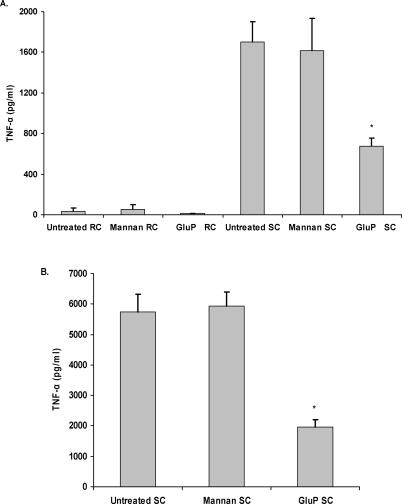
Competitive Carbohydrate Blockage Indicates No Role of Mannan Receptors in the Inflammatory ResponseAlveolar macrophages (A) or RAW 264.7 macrophages over-expressing dectin-1 (B) were pretreated with 250 μg/ml S. cerevisiae-derived mannan or 100 μg/ml glucan phosphate and then added to RC or SC. Thereafter, cytokine and chemokine levels were determined in supernatants by Bio-Plex or ELISA. Each graph illustrates cumulative results from four separate experiments. Asterisks represent significant differences between untreated and glucan-phosphate treated (p < 0.05).